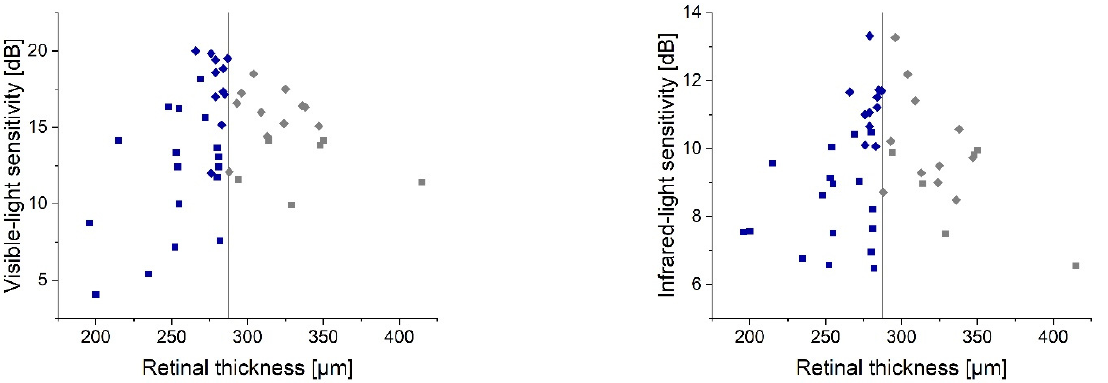
Figure 8. The relationship between the central subfield thickness of AMD (squares) and control (diamonds) subjects and retinal sensitivity measured using single- and two-photon approaches. The vertical line shows the median (reference) level found in the control group. The retinal thicknesses above and below the reference are marked in gray and blue, respectively.